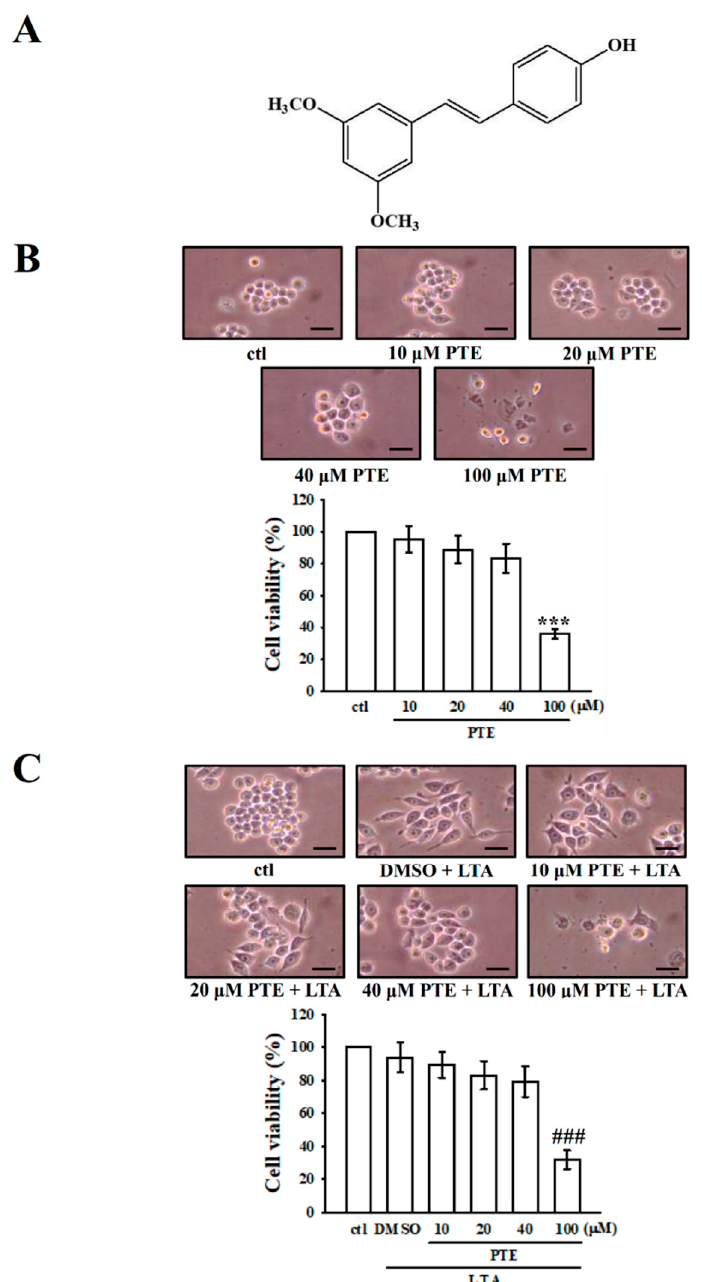
Figure 1. ( A ) The chemical structure of pterostilbene (PTE). 3-(4,5-dimethylthiazol-2-yl)-2,5-diphenyltetrazolium bromide (MTT) cell viability assay and morphology of ( B ) PTE (10–100 µM) alone and ( C ) PTE pretreated lipoteichoic acid (LTA)-induced RAW 264.7 cells as described in the method section. Scale bar = 25 µm. Data offered are the means ± standard error (S.E.M.) ( n = 4); *** p < 0.001 vs. control cells; ### p < 0.001 vs. LTA induced cells.